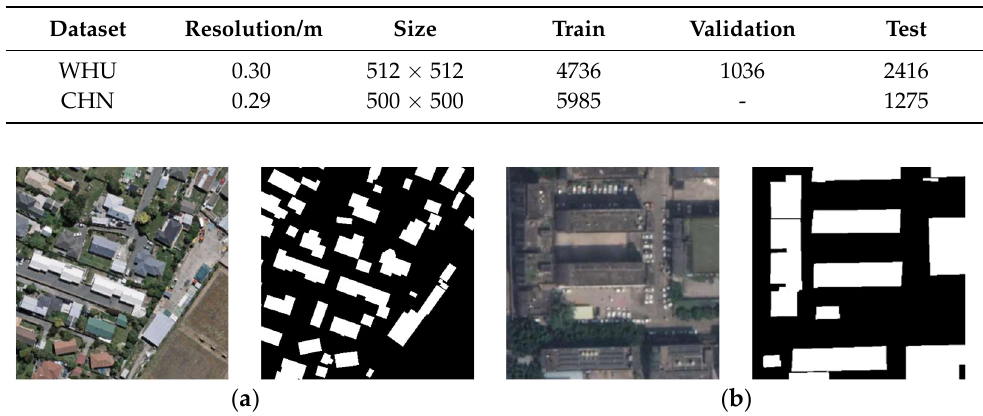
Table 1. Basic parameters and training assignment of dataset.